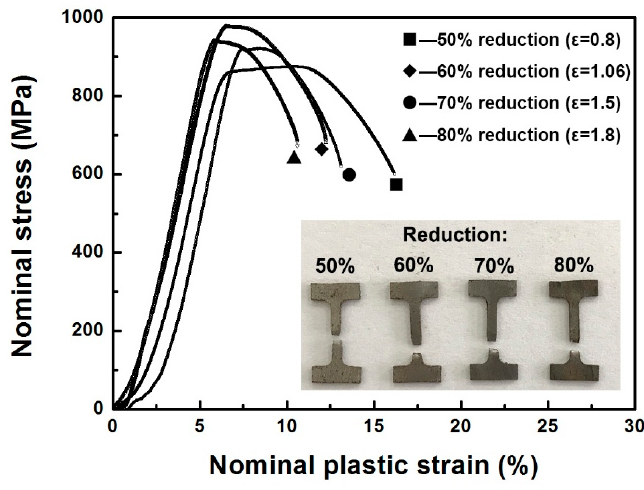
Figure 10. Stress-strain curves of specimens with different reductions.